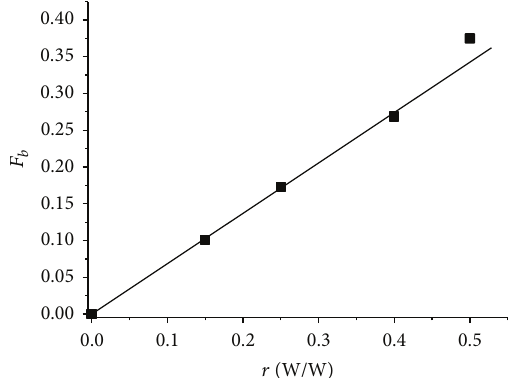
Figure 5: The fraction of DNA bound to the nonhistone protein HMGB1 𝐹 𝑏 as a function of protein to DNA ratio 𝑟